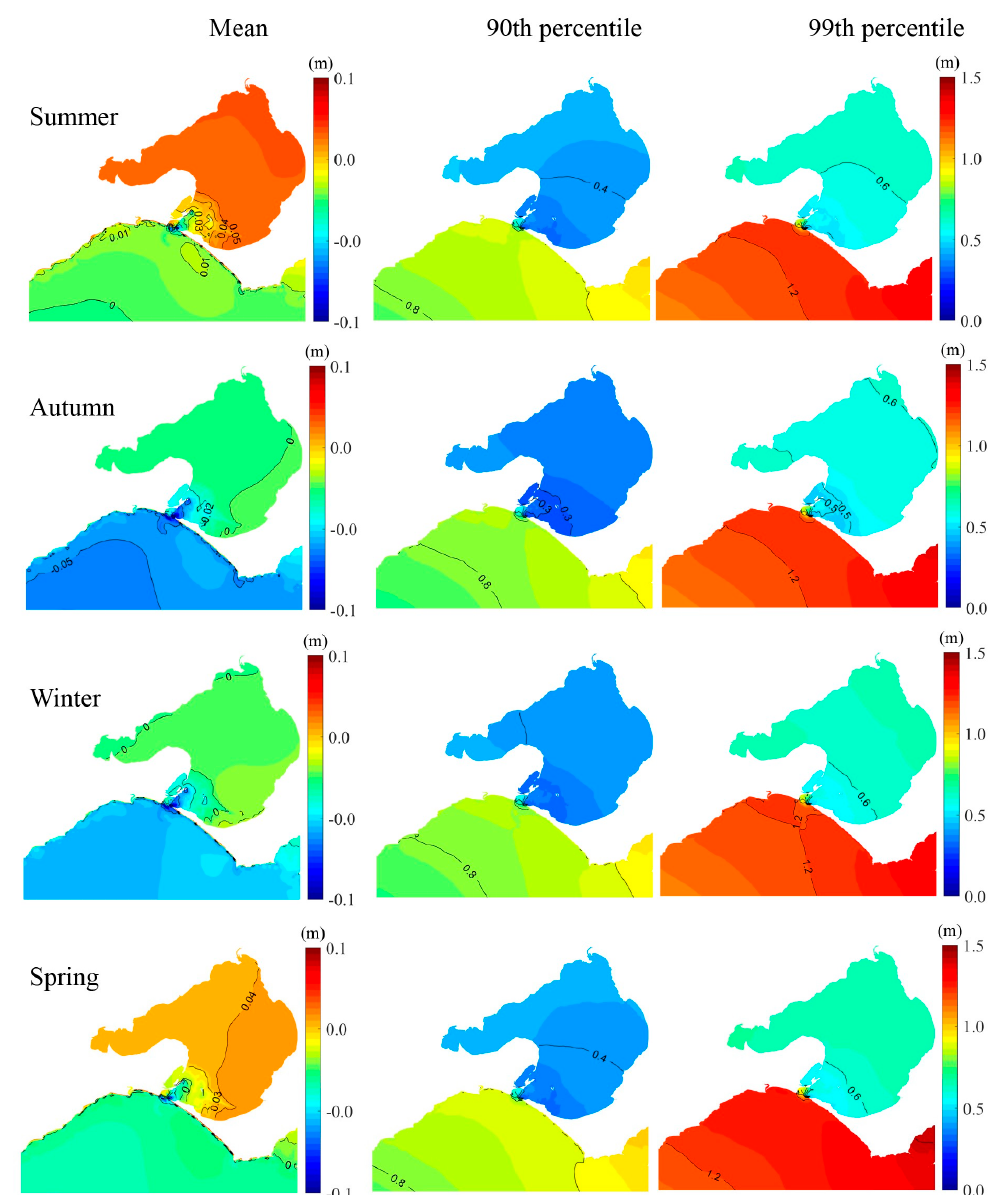
Figure 8. Seasonal variations in sea levels with respect to the mean value, 90th and 99th percentiles. The MSL in PPB shows a strong influence of seasonality.